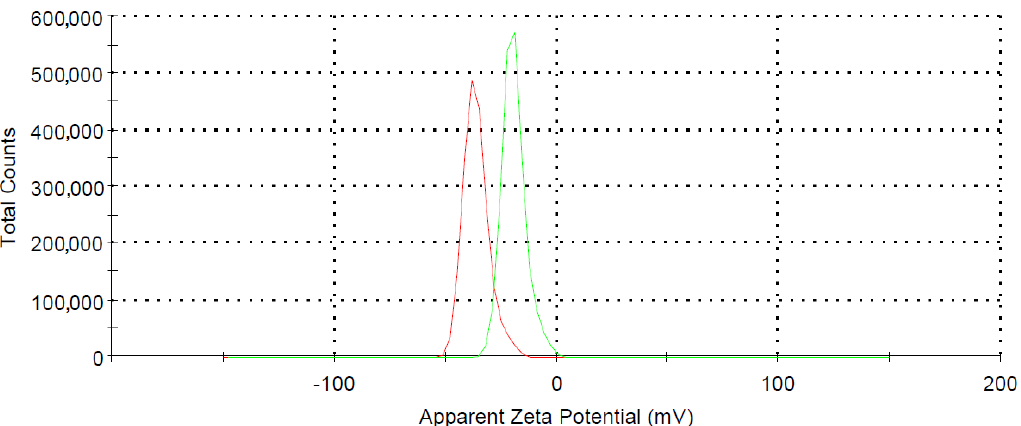
Figure 2. X-ray diffractograms: Fe 3 O 4 NPs ( a ) and Ch- Fe 3 O 4 NPs ( b ).